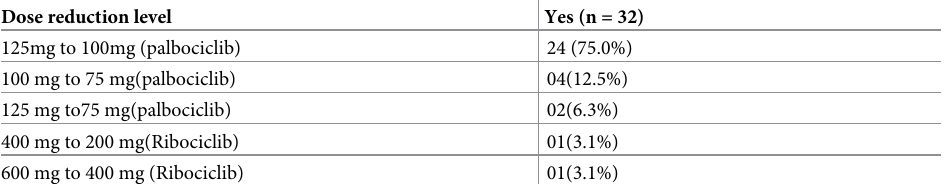
Table 3. Dose reductions of palbociclib and